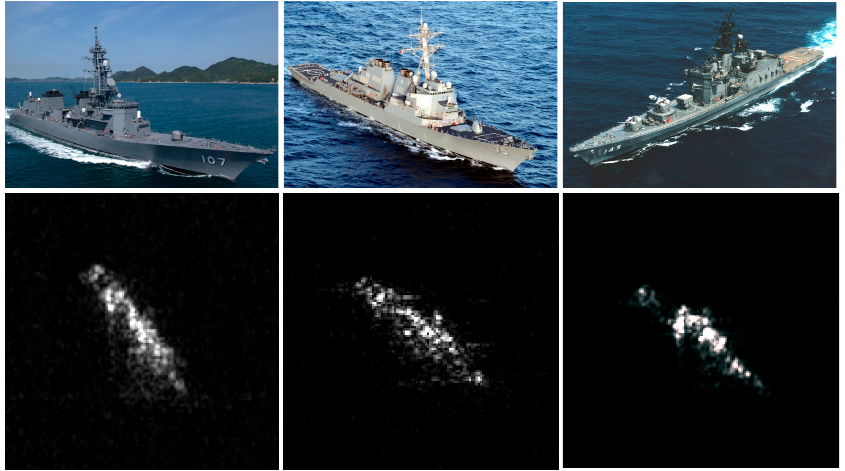
Figure 1. The optical and synthetic aperture radar (SAR) images of different types of ships.